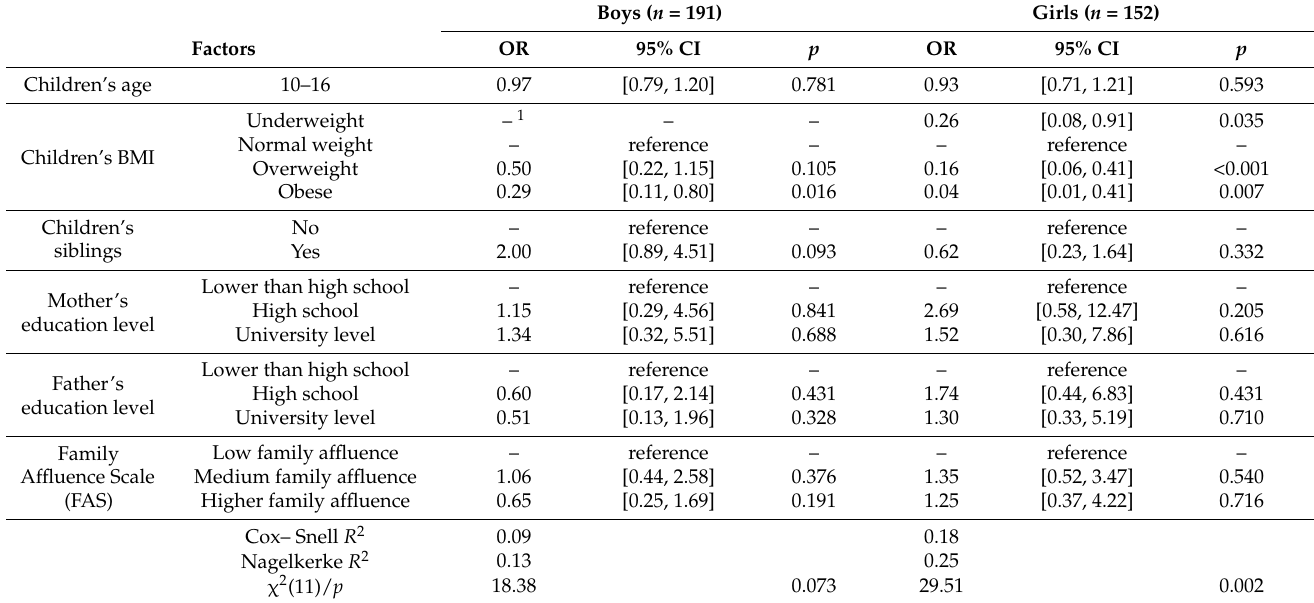
Table 2. b. Predictors of parents’ accuracy in identifying children’s weight category, by sex.